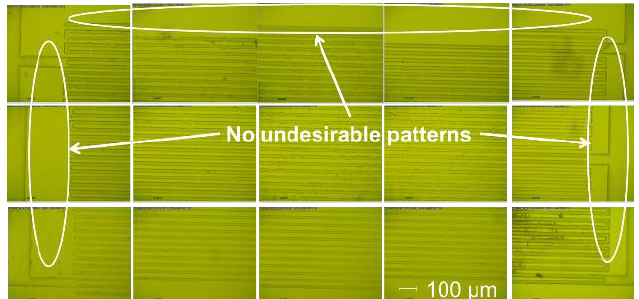
Figure 11. Microscopic image of undesirable patterns being removed when adding O 2 plasma in RIE mode for 15 s.